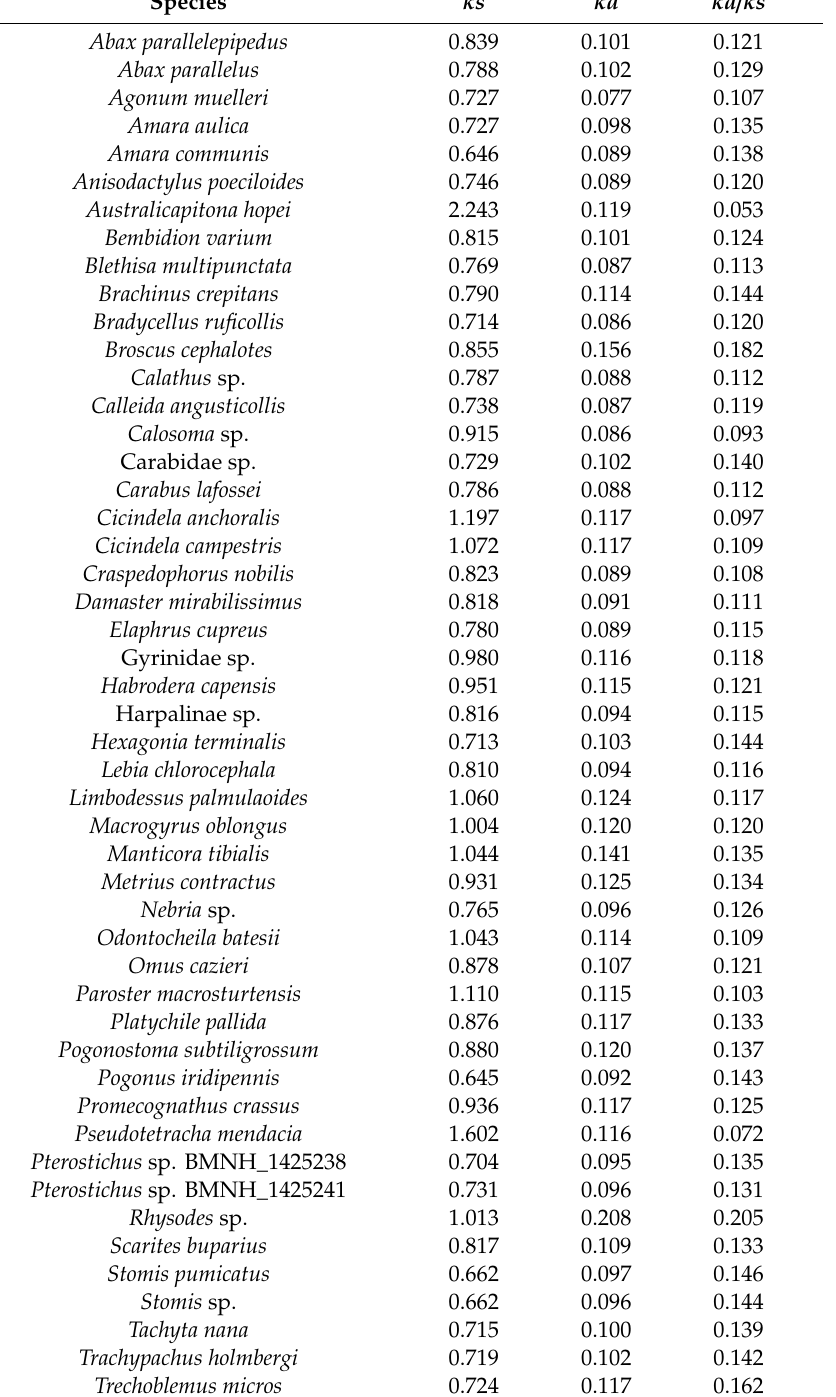
Table 4. The substitution rate analyses conducted by